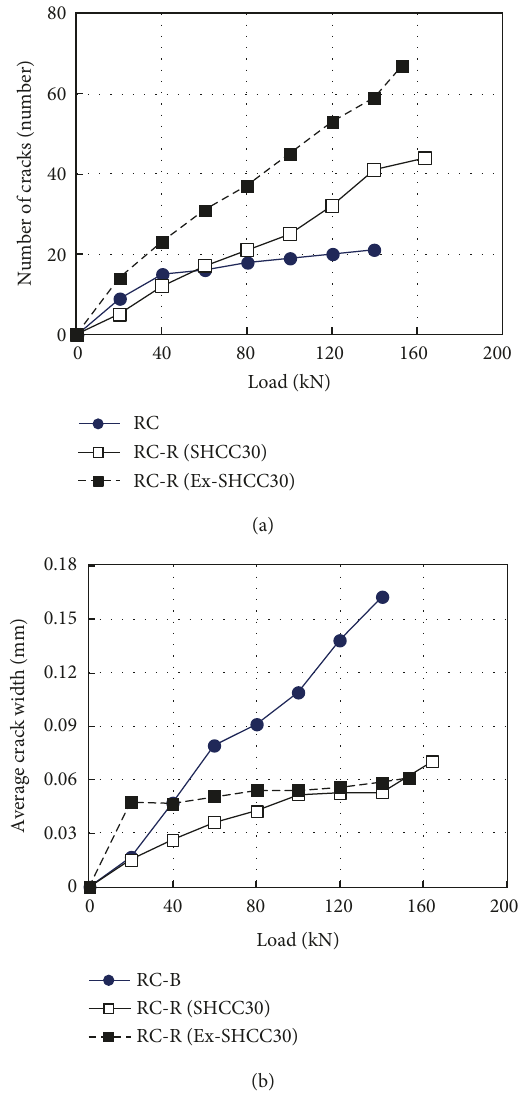
Figure 9: Cracking behavior of beam specimens. (a) Number of cracks. (b) Average crack